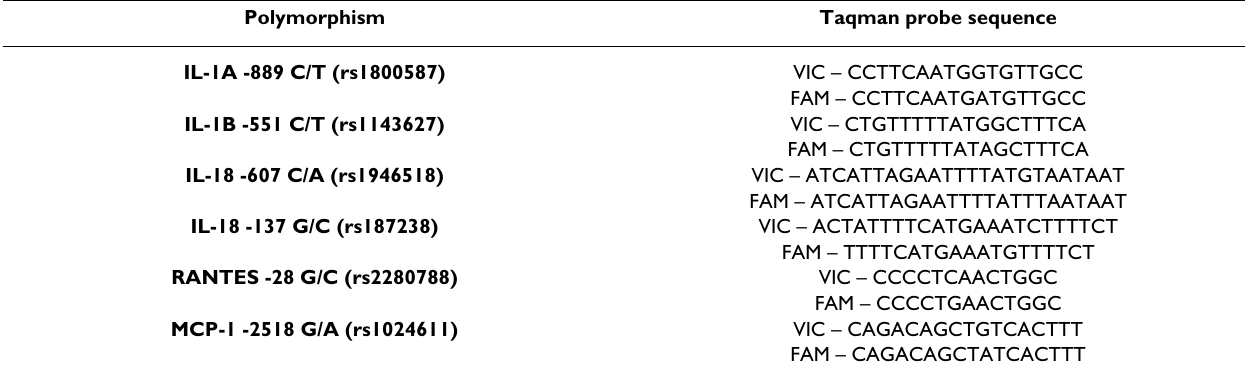
Table 1: Taqman probes used for cytokine genotyping Polymorphism